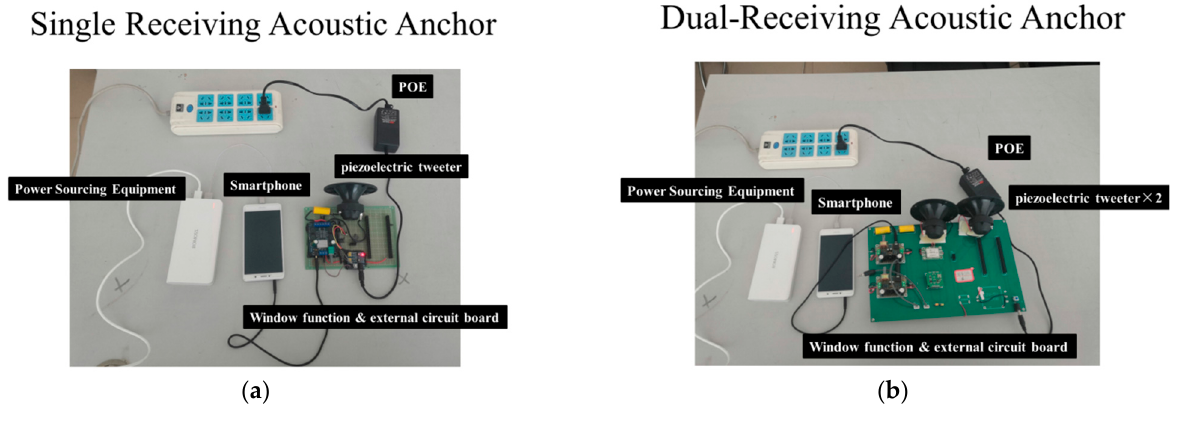
Figure 3. Different kinds of acoustic anchors. ( a ) Single receiving acoustic anchor; ( b ) Dual-receiving acoustic anchor.